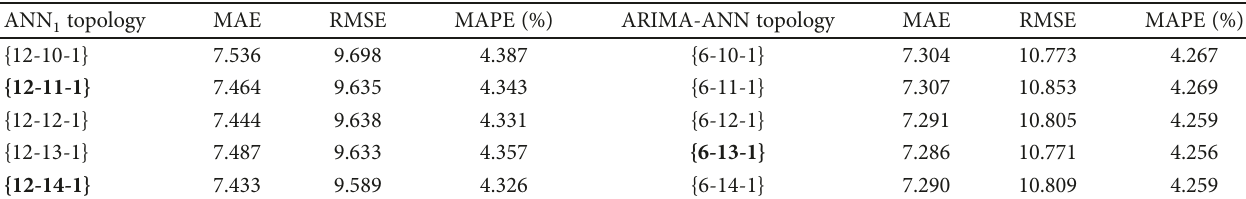
Table 14: The results of MARS